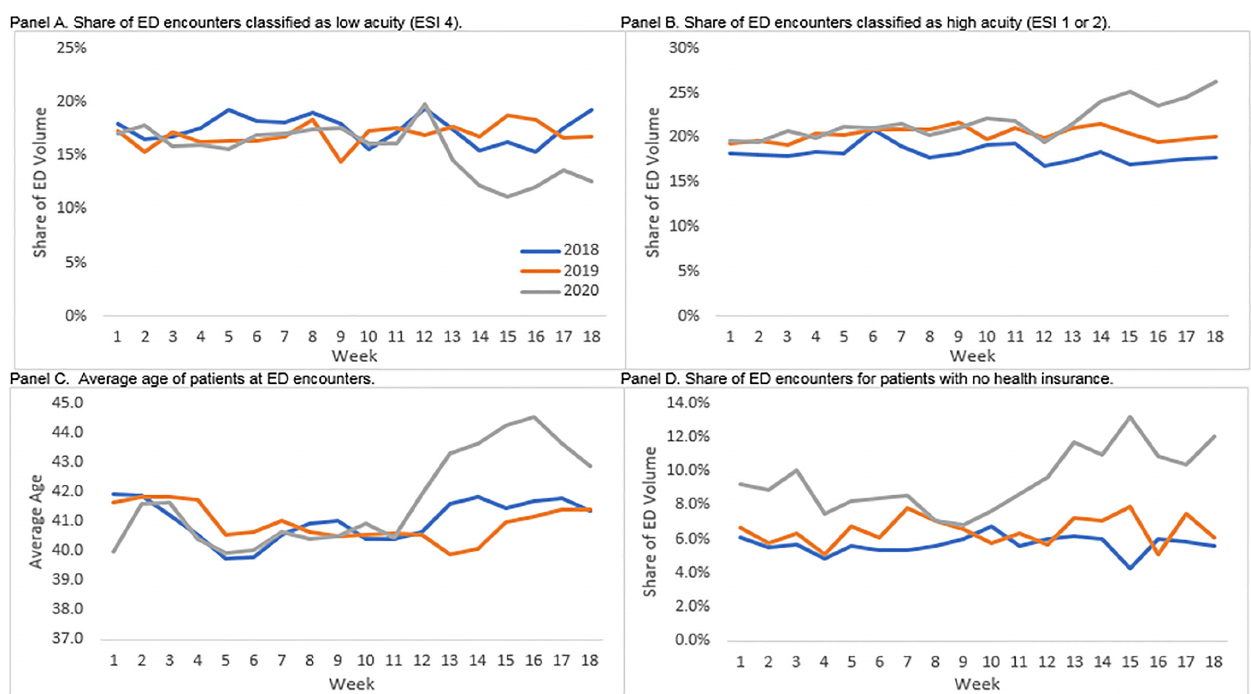
Figure 2. Distribution of emergency department (ED) volume by week, year, and selected characteristics.